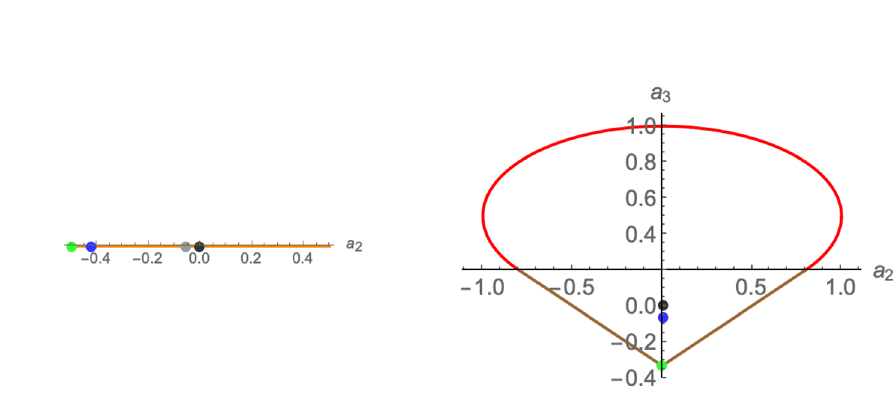
Figure 4. (left) The coefficient region for N = 2 in the a 2 space.(Right)The coefficient region for N = 3 in ( a 2 , a 3 ) space.